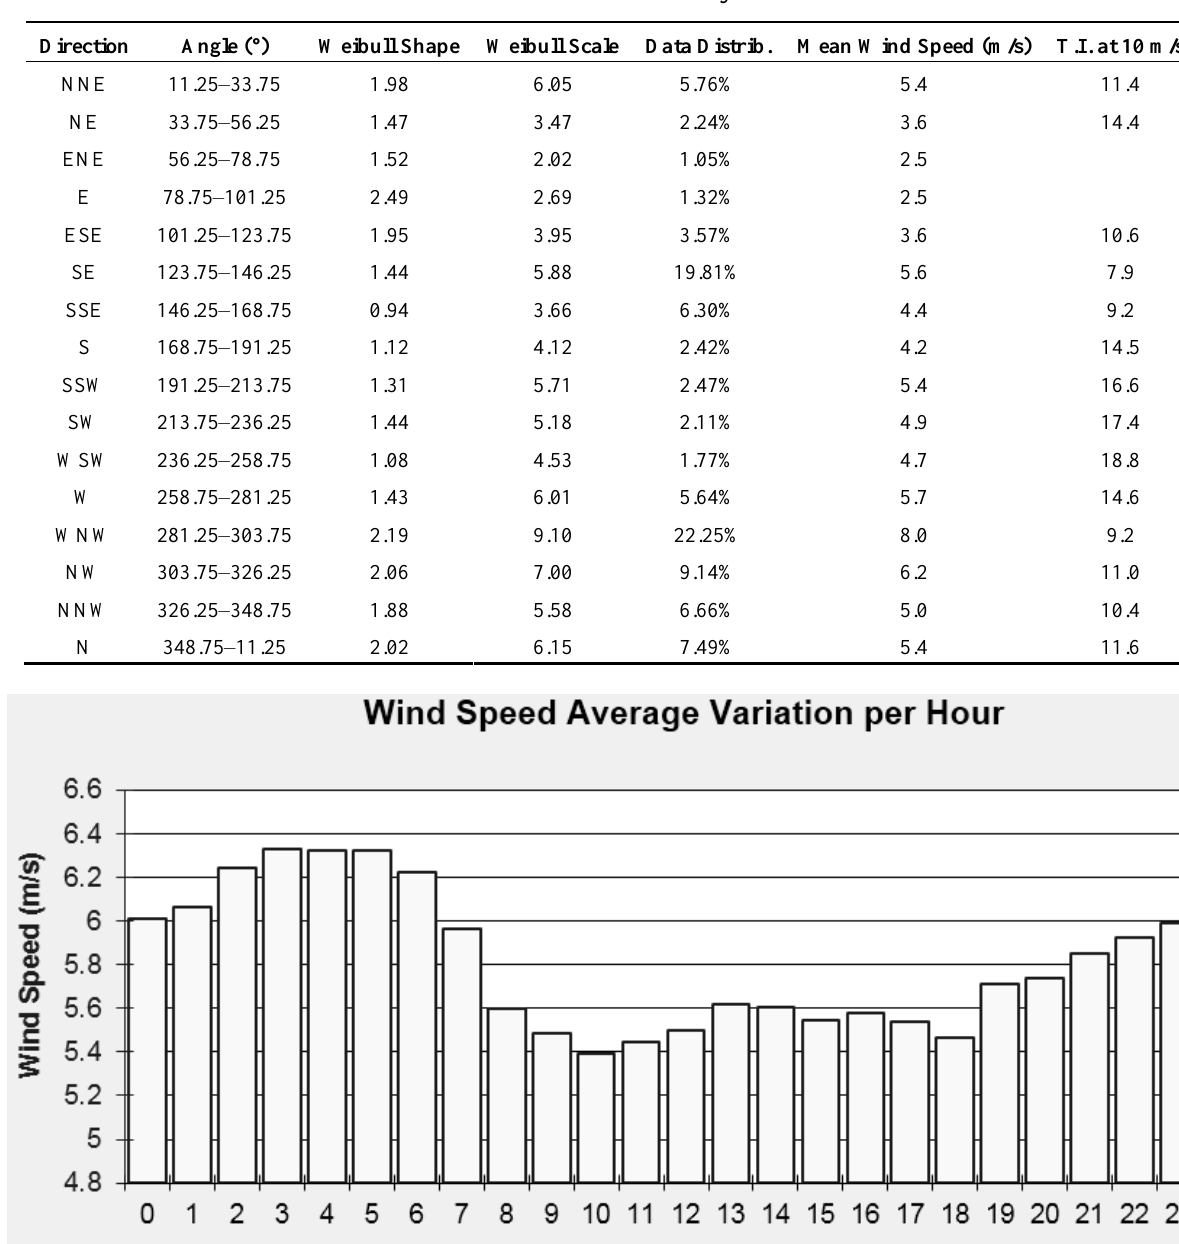
Table 2. Weibull distribution analysis of the mast.